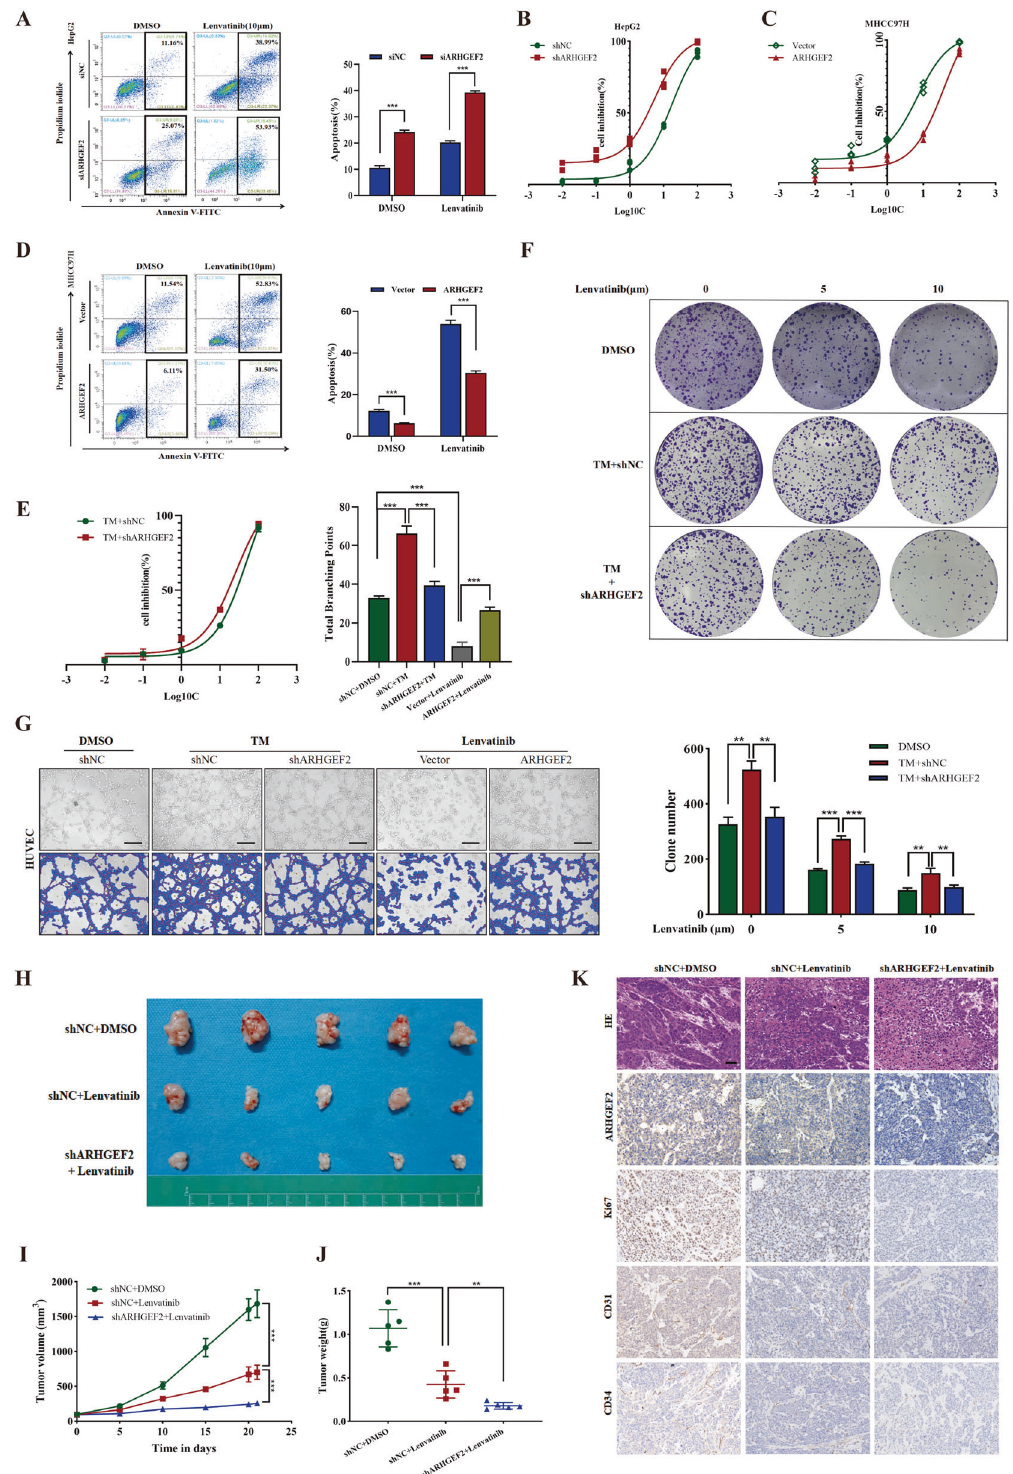
Fig. 6 ARHGEF2 was involved in the resistance of lenvatinib. A After interfering with the expression of ARHGEF2 in the HepG2 cell line, detected the sensitivity of cells to lenvatinib by fl ow cytometry. B The IC50 value of lenvatinib was measured in ARHGEF2 knockdown and control HepG2 cells. C The IC50 value of lenvatinib in ARHGEF2 overexpression and control MHCC97H cells. D Flow cytometry were used to detected the sensitivity of cells to lenvatinib in ARHGEF2 overexpression and control MHCC97H cells. E The IC50 value of lenvatinib in TM- treated HepG2 cells with or without ARHGEF2 knockdown. F The proliferation ability of the HepG2 cells with different treatments were detected by clone formation assay. G Representative images of tube forming ability of HUVEC cells treated with different CM. H Tumors from mice after different treatments. I , J Measurement of tumor volume ( I ) and weight ( J ). K The expressions of Ki67, CD31, CD34 and ARHGEF2 in different groups were detected by IHC.